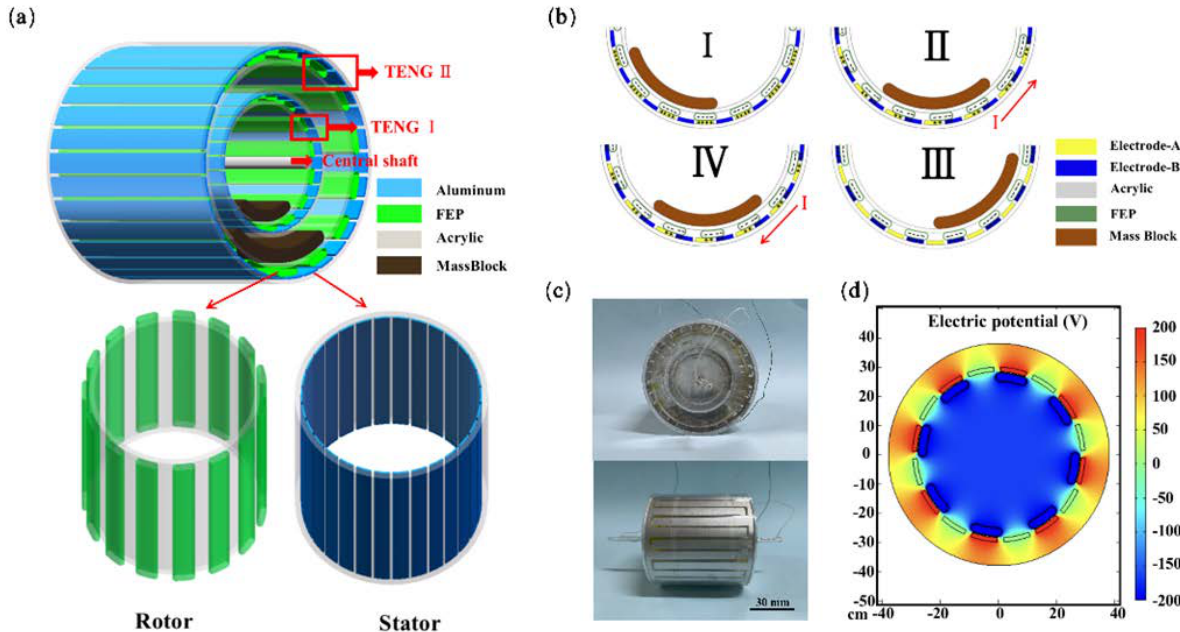
Figure 1. Schematic diagram of the structure and working principle of the sleeve-type TENG. ( a ) The structural design of the MC-TENG including the internal rotor and the external stator. ( b ) Charge distribution during the MC-TENG rotor oscillation. ( I – IV ) ( c ) Photograph of the MC-TENG. ( d ) The potential distribution of MC-TENG was calculated by the COMSOL simulation.